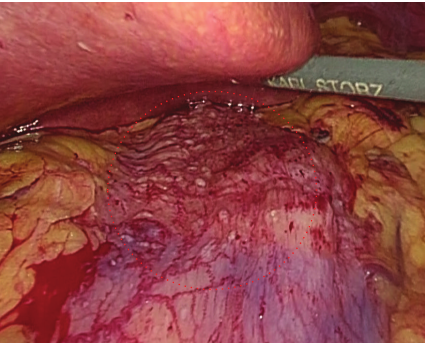
Figure 2: Intraoperative picture. There were multiple small nodules on serosal surface of upper